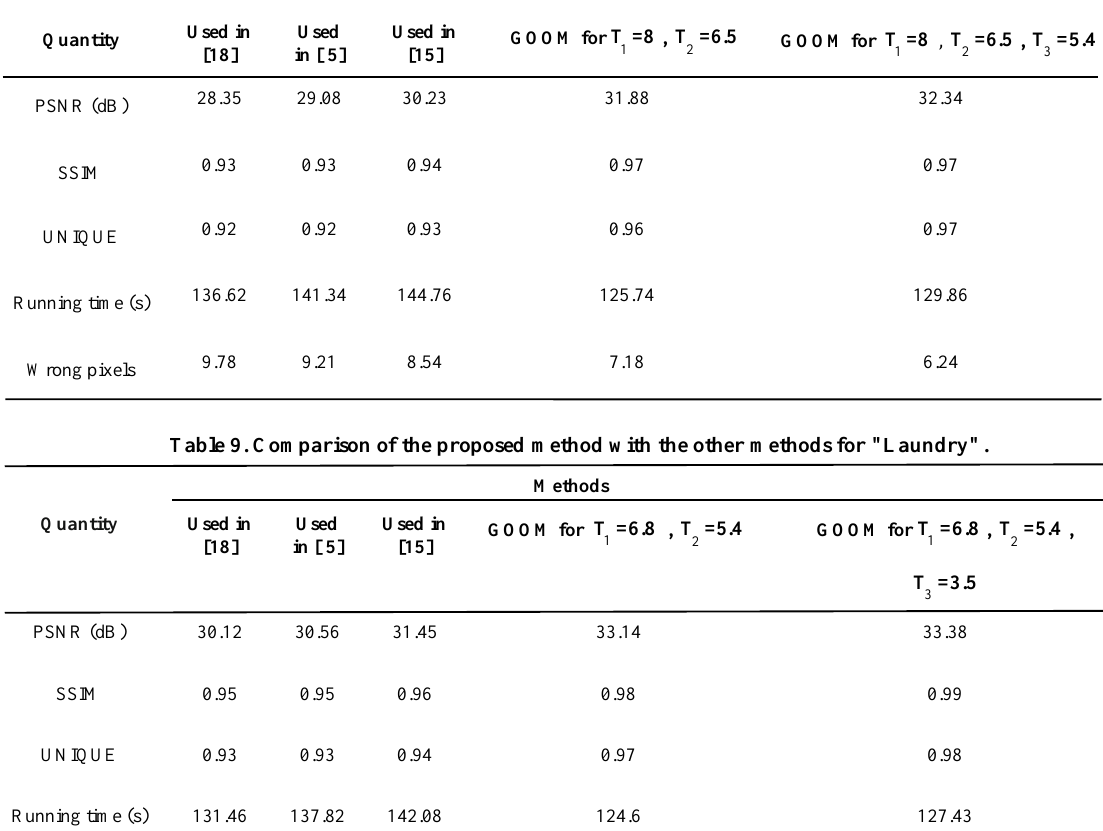
Table 8. Comparison of the proposed method with the other methods for "Dolls". Methods